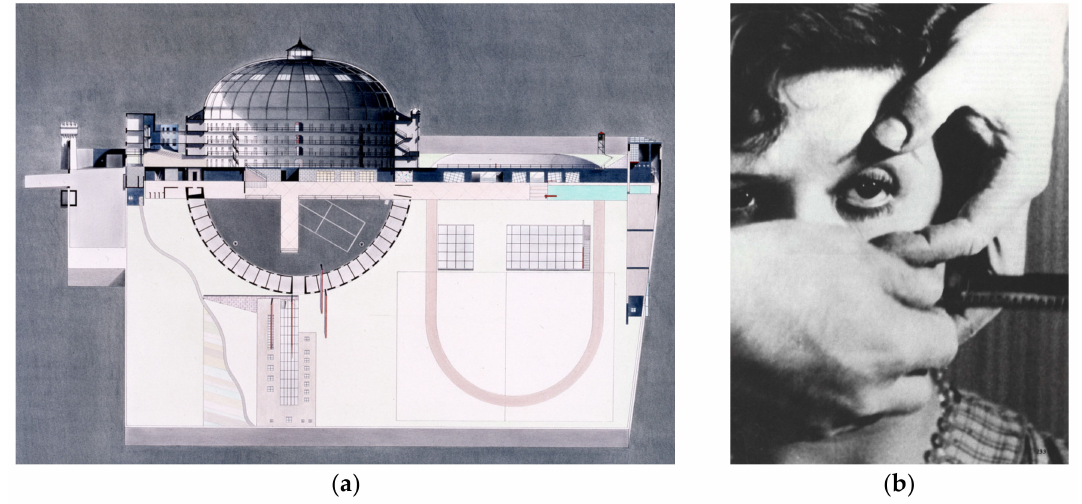
Figure 7. The intervention proposal for the Koepelgevangenis in Arnhem. ( a ) The project: interior perspective drawing, by R. Koolhaas / OMA, 1979-80; ( b ) a photogram of Un Chien Andalou , L. Buñuel and S. Dal í , 1929. Koolhaas compared this with the way in which the intersection of the new streets eliminates “the eye” of the